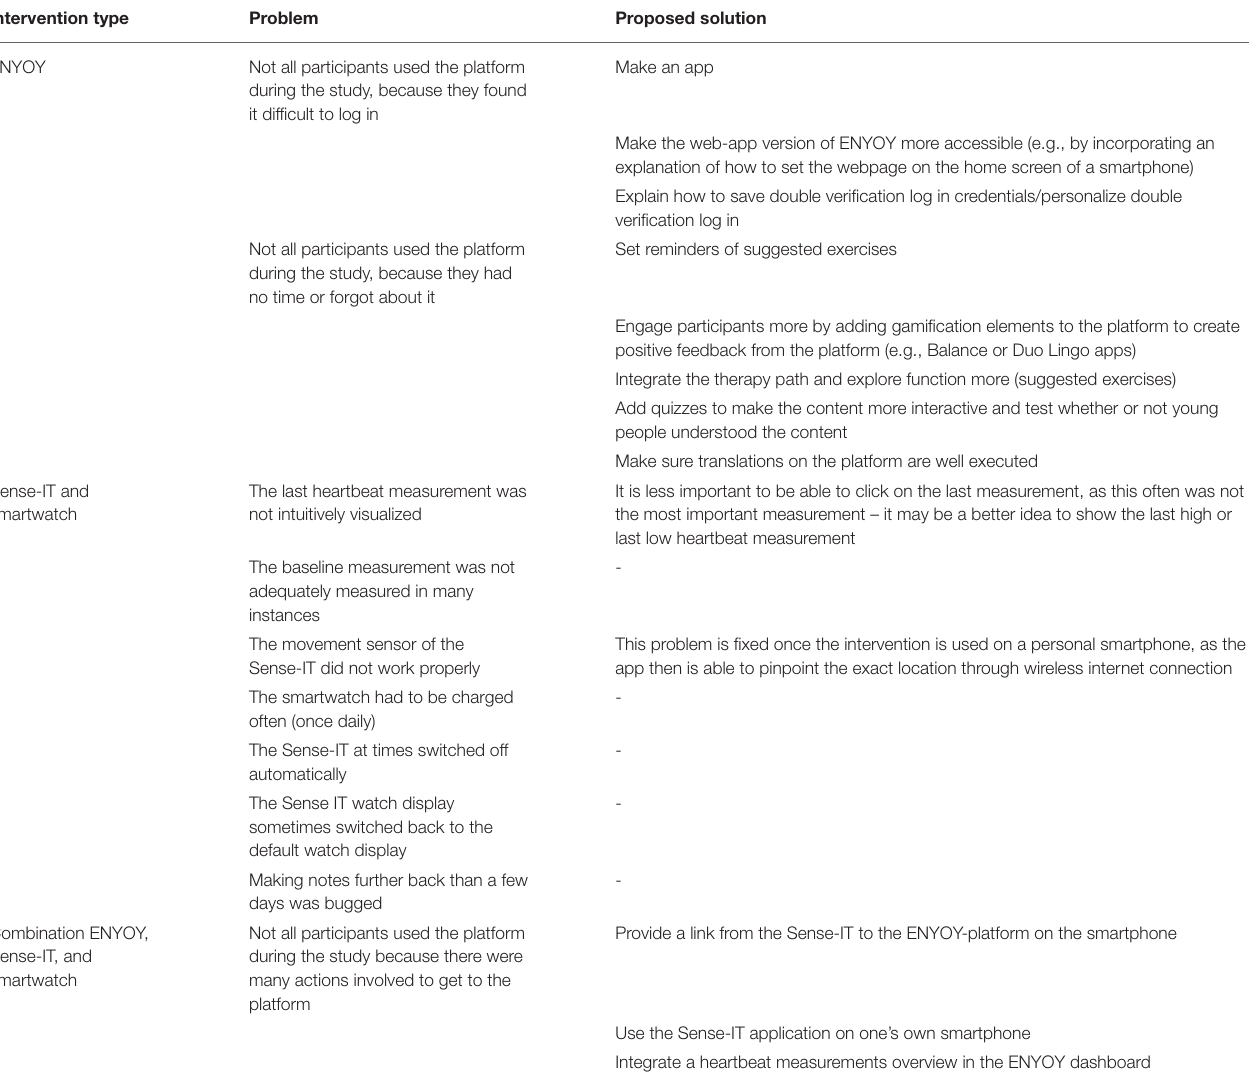
TABLE 3 | Overview of bugs, problems and proposed solutions from the semi-structured evaluative interviews. Intervention